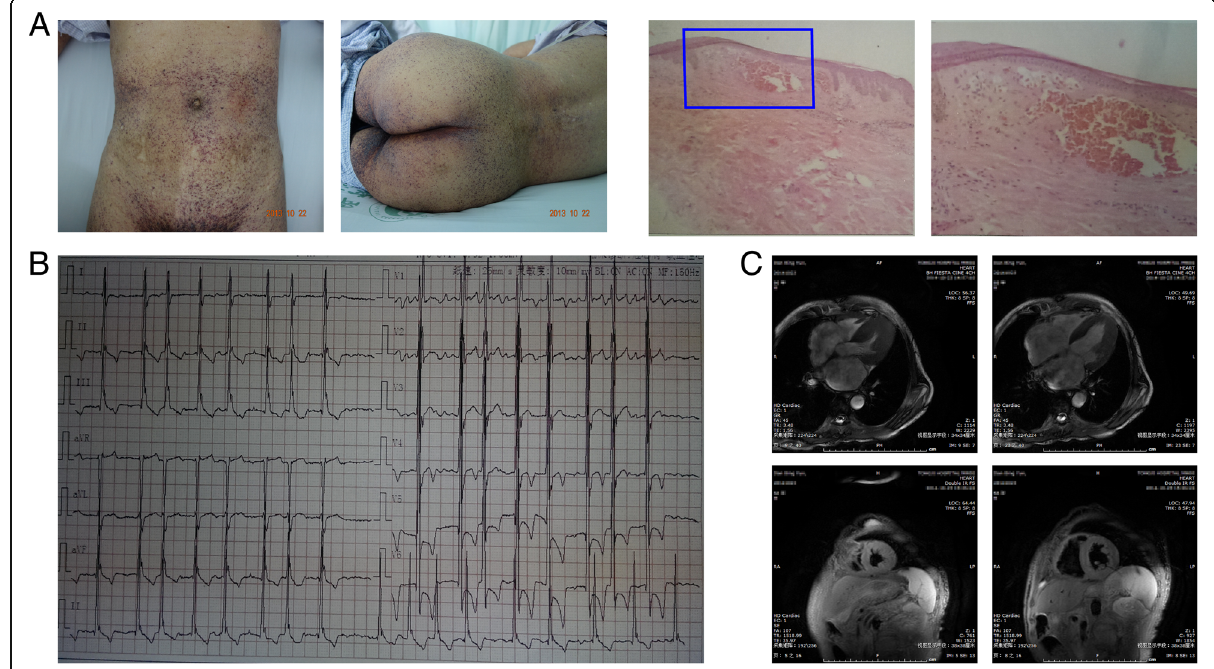
Fig. 2 Clinical characteristics of the proband in this pedigree. a Pictures of skin rashes in the groin and on the back of the patient (Capillary balloons dilated on the surface of the skin are distributed as clusters or grape-like spots. The rash can be purplish red or red black when it is accompanied by venous bleeding, and excessive skin rash can be hyperkeratosis) and histopathology of skin biopsy (A wide range of crystallized sugar sphingomyelin deposits in the tissue can be observed under the microscope, and the histopathological diagnosis is angiokeratomas). b The electrocardiogram of the patient indicating atrial fibrillation rhythm, high voltage in the left ventricular, and T wave inversion in all precordial leads. c Cardiac magnetic resonance imaging showing apparent left ventricle hypertrophy at the apical region and the septum. The upper two pictures represent the sagittal plane of the heart, and the two lower figures show the coronal plane of the